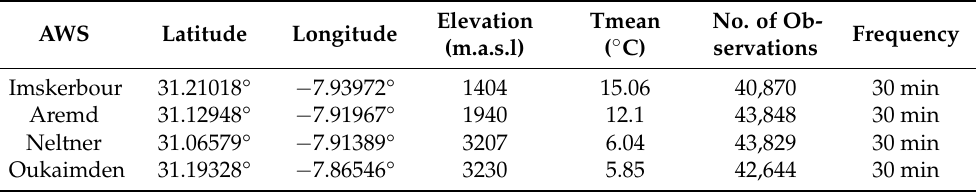
Elevation Tmean No. of Ob- (m.a.s.l) ( ◦ C)